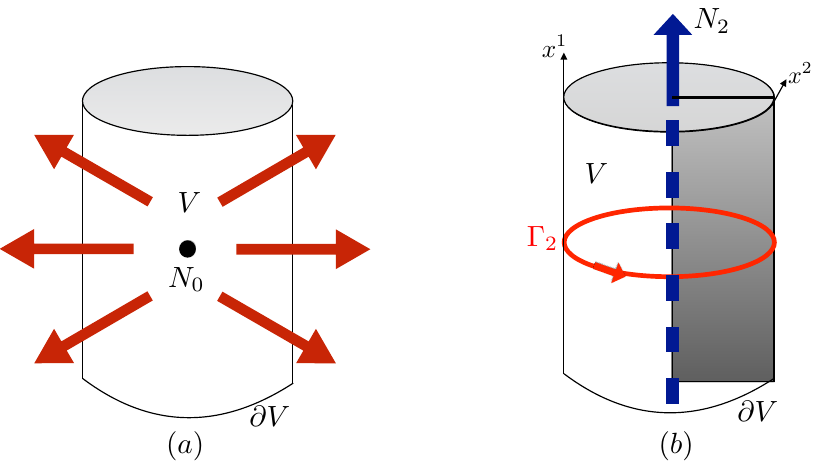
Figure 8 . (a) Flux due to the electric charge N 0 in the bulk. (b) Bulk vortex of magnetic charge N 2 along x 1 and closed line (cid:0) 2 encircling it on the surface. In grey the branch cut surface from the vortex excitation to the